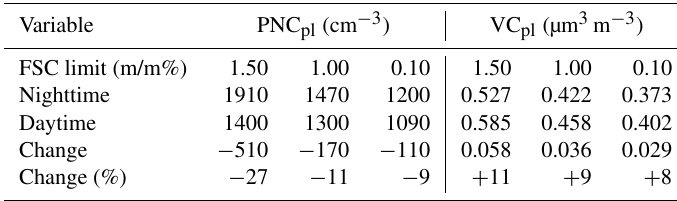
Table 2. Particle number (PNC pl ) and volume concentrations (VC pl ) of plumes during the three different fuel sulfur content (FSC) restriction periods, and the change in concentrations between daytime and